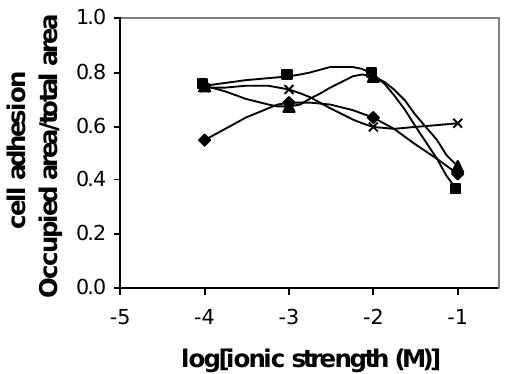
Figure 2. Adhesion of Yarrowia lipolytica IMUFRJ to polystyrene at pH 3 ( ), pH 5 ( ■ ), pH 7 ( ▲ ), and pH 9 (x) and ionic strength varying from 10 −4 M to 10 −1 M. The error bars are omitted for a clearer visualization. The standard deviation varied from 2% to 10%.